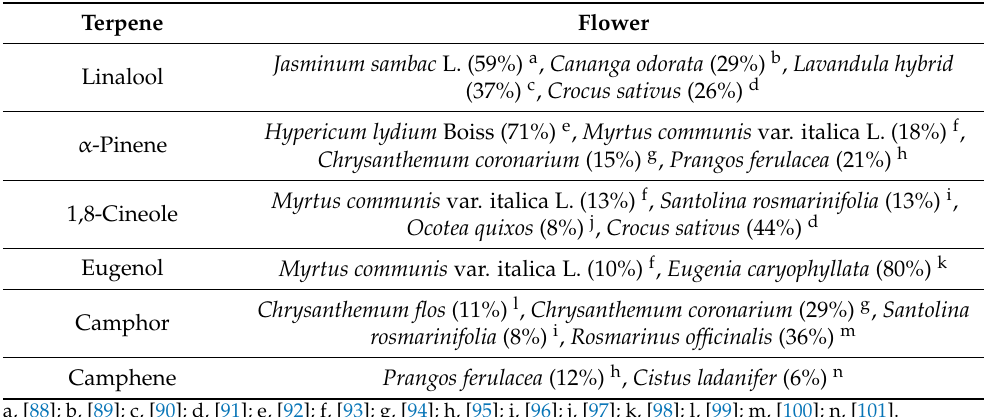
Table 11. Major terpenes detected in some edible flowers’ essential